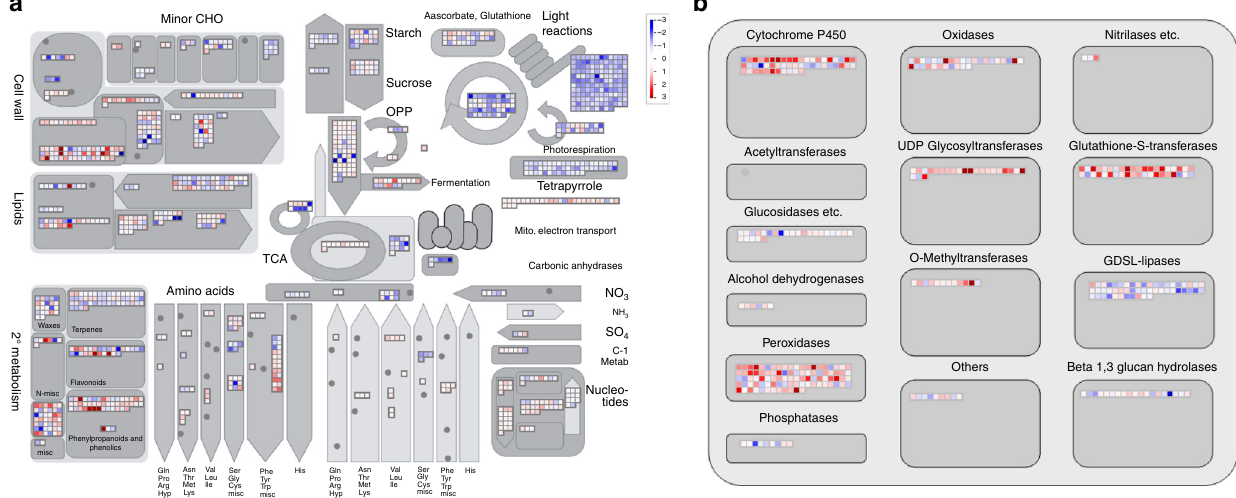
Fig. 3 The allelopathic transcriptomic pro fi les of barnyardgrass against rice. a An overview for diverse pathways and b transcriptomic pro fi le for large enzyme families visualized by Mapman. Color intensity corresponds to the expression fold change at log2 scale (red: up-regulated, blue: down-regulated)